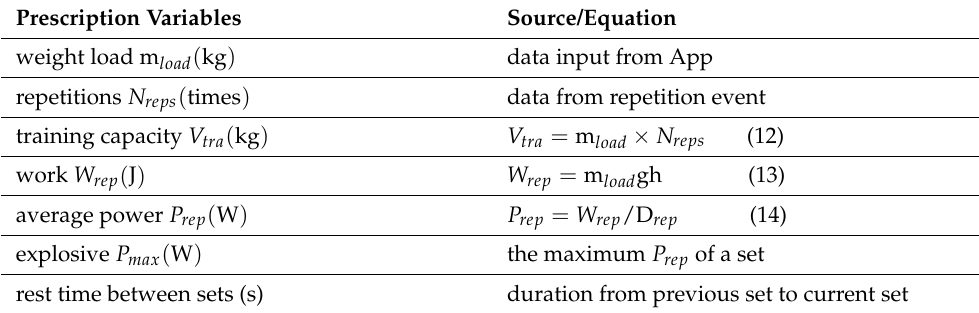
Table 2. List of exercise prescription variables.